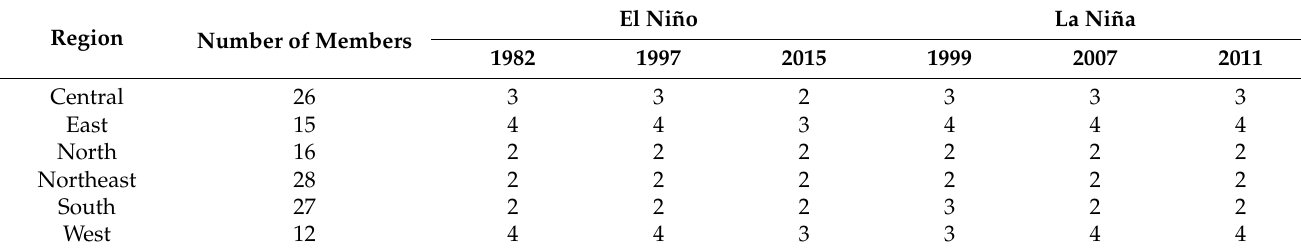
Table 4. The distribution of SGs over six regions for